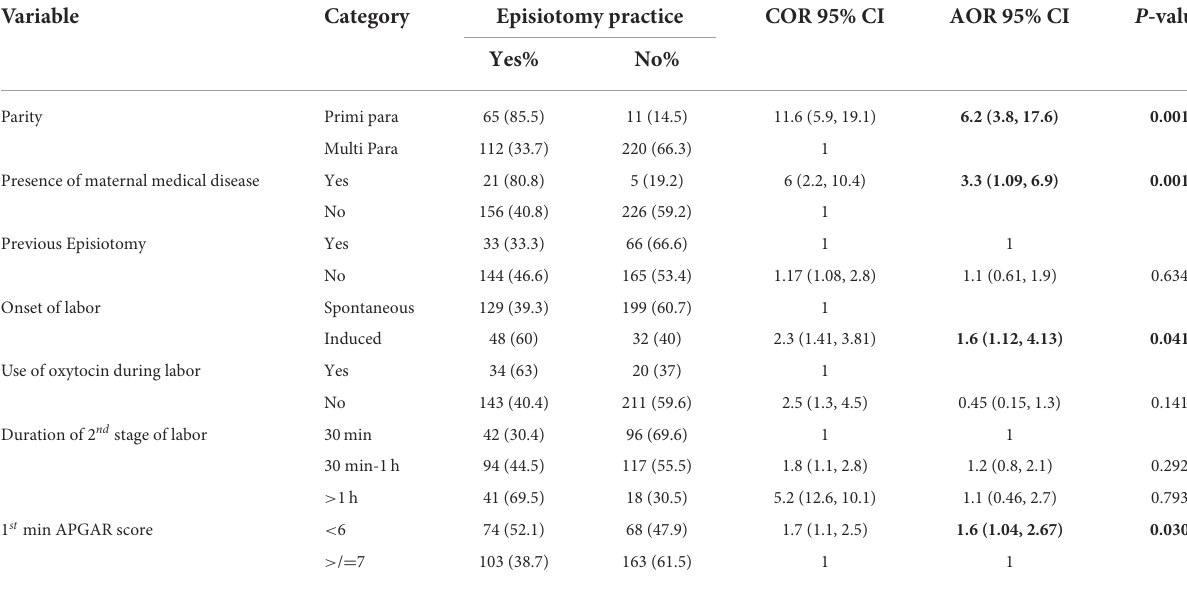
TABLE 3 Factors associated with episiotomy practice among mothers who gave birth at the HFSUH, 2021.